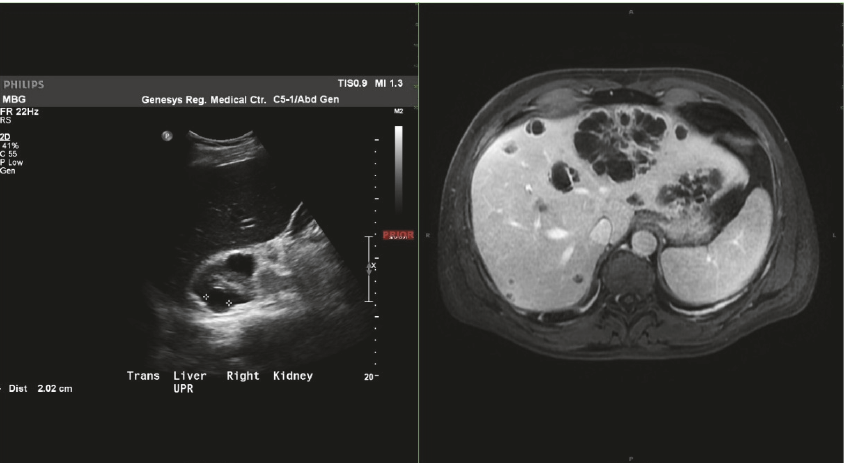
Figure 1: Transverse imaging showing initial negative ultrasound (left) and follow-up MRCP showing liver abscesses (right).